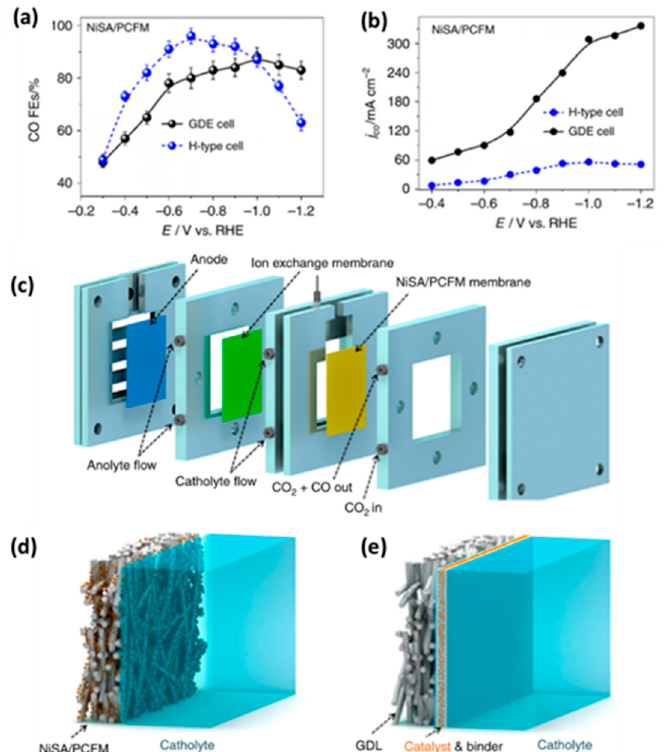
Figure 7. Example of application of Ni – N – C type catalyst as GDE for a flow-electrolyte cell. ( a ) CO faradaic efficiencies; ( b ) Partial current densities as functions of the applied potential vs. RHE of NiSA/PCFM in both H-type cell and GDE flow-cell; ( c ) Representation of a GDE device; ( d ) NiSA/PCFM membrane adopted as GDE; ( e ) A typical GDE cell in which the catalyst is located onto a gas-diffusion layer through a polymer binder. Adapted with permission from Ref. [63]. Copyright 2022 Springer Nature.